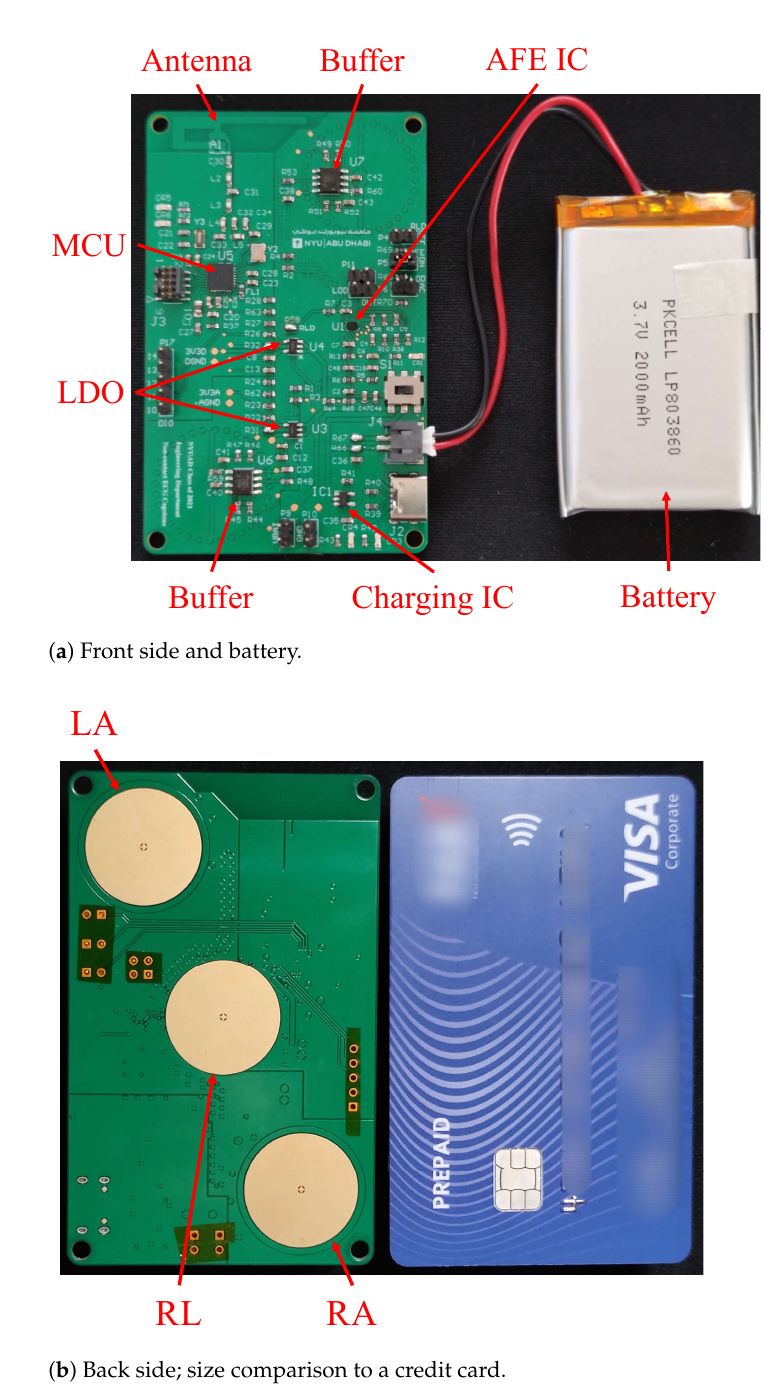
Figure 3. Photos of the device’s physical